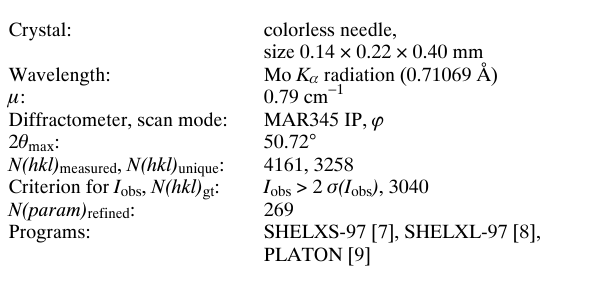
Table 1. D a t a collection a nd h a